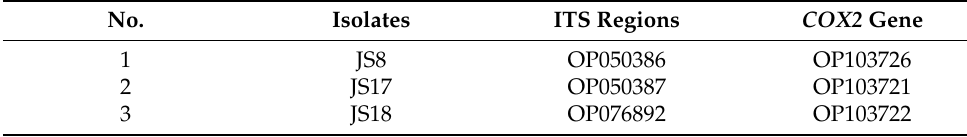
Table A1. Sequences used for concatenated